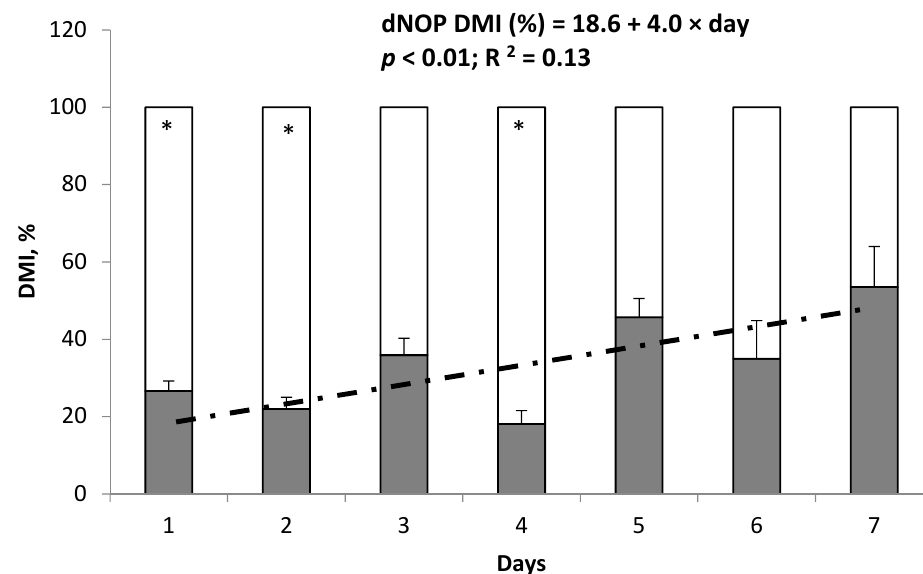
Figure 1. Proportions of DMI of beef steers ( n = 9) fed a high forage diet without (white portion of the bars) or with 3-NOP (black portion of the bars) during the preference period (Exp. 1). The symbol * indicates that the proportion of the CON diet consumed minus proportion of the 3-NOP diet consumed within day is not equal to 0 ( p < 0.05). Day 1 to 7 corresponds to the 7 d preference period. The dashed line indicates the linear regression of intake of 3-NOP diet, as a percentage of total daily dry matter intake (dNOP DMI, %), as a function of day during the preference period. p = 0.015; R 2 = 0.09